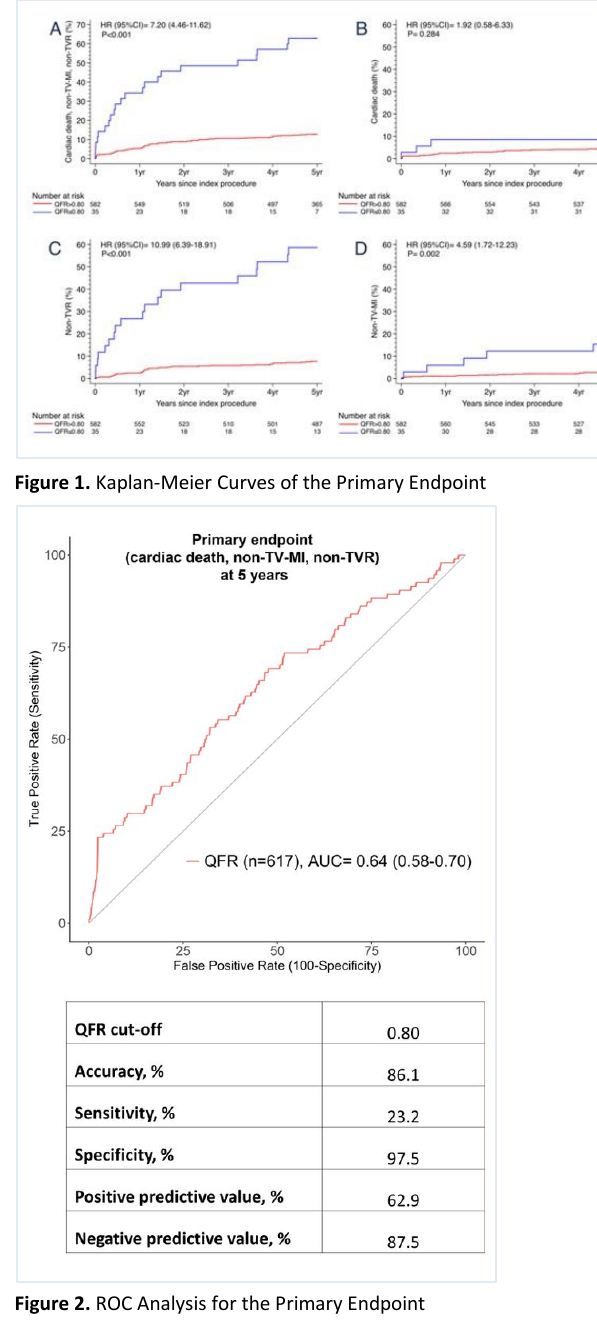
Figure 2. ROC Analysis for the Primary